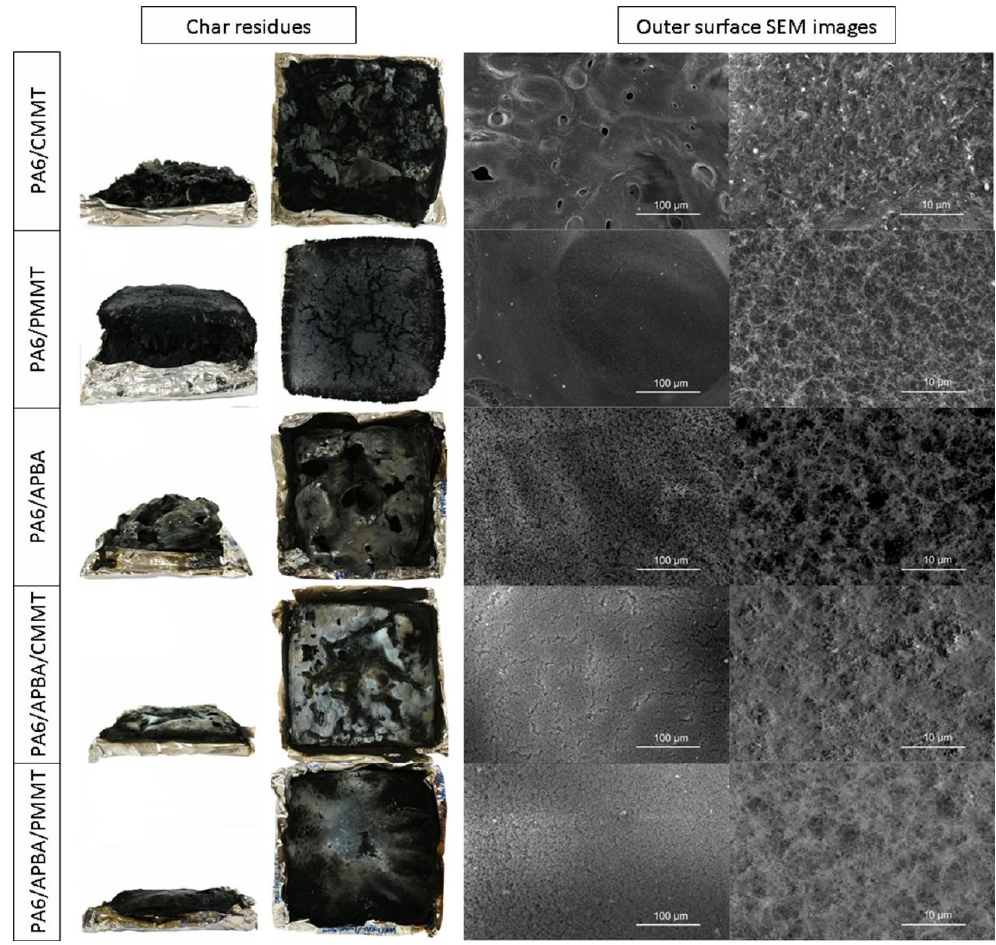
Figure 8. Photographs (the left two rows) and SEM images at different magnifications (the right two rows) of the residues after the cone calorimeter tests for PA6 and PA6 composites.